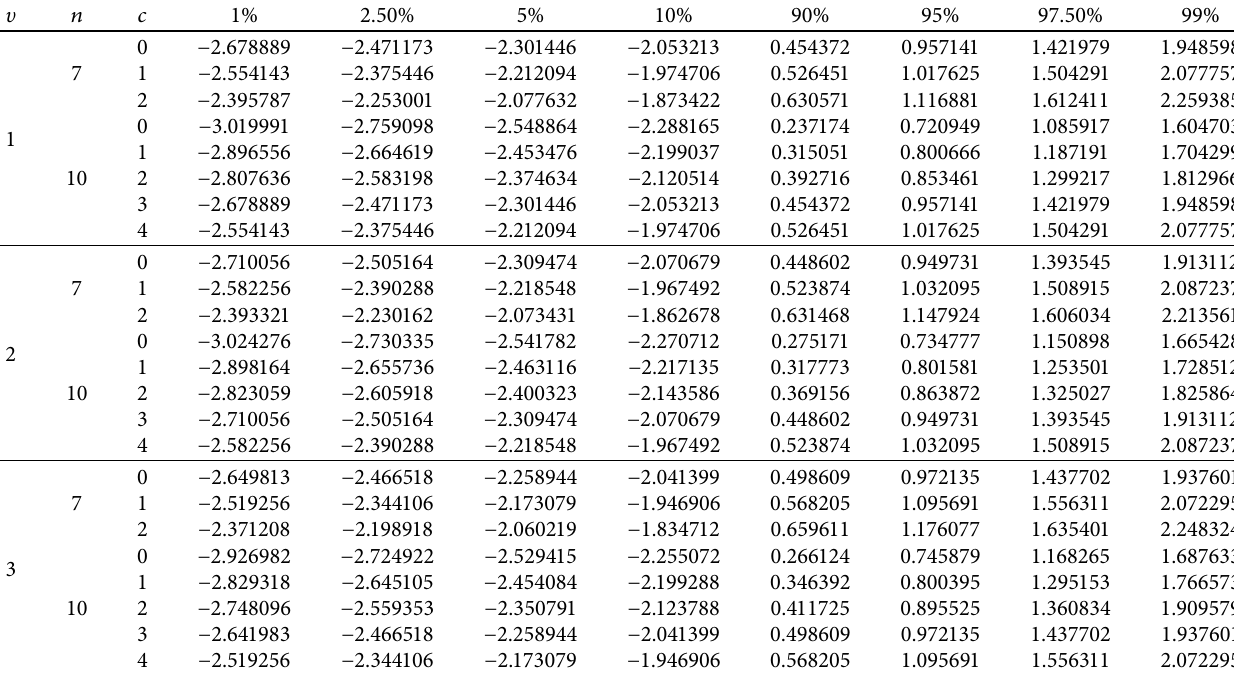
when μ � 0 and σ � 2